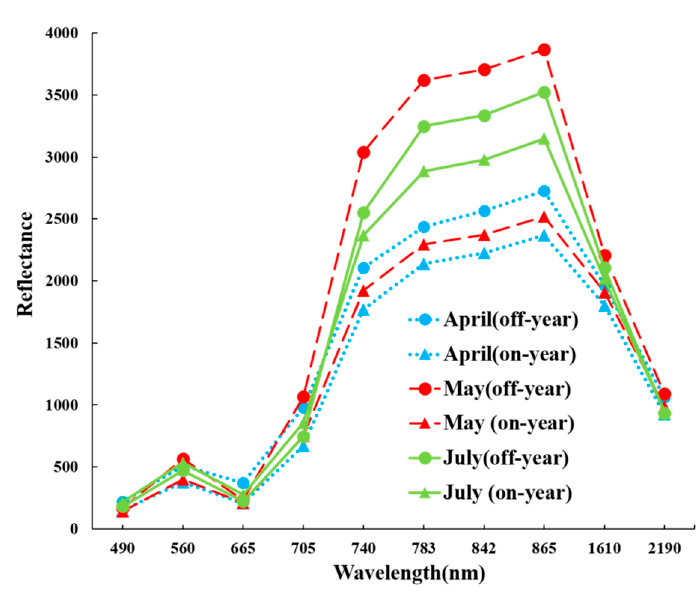
Figure 5. Spectral curves of on-year and off-year bamboo forest at different dates.